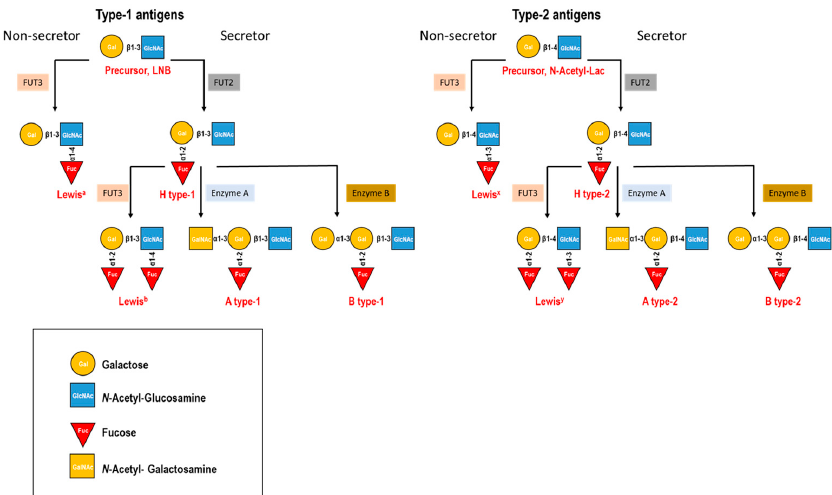
Figure 1. Biosynthesis routes and schematic structure of histo-blood group antigens (HBGAs)